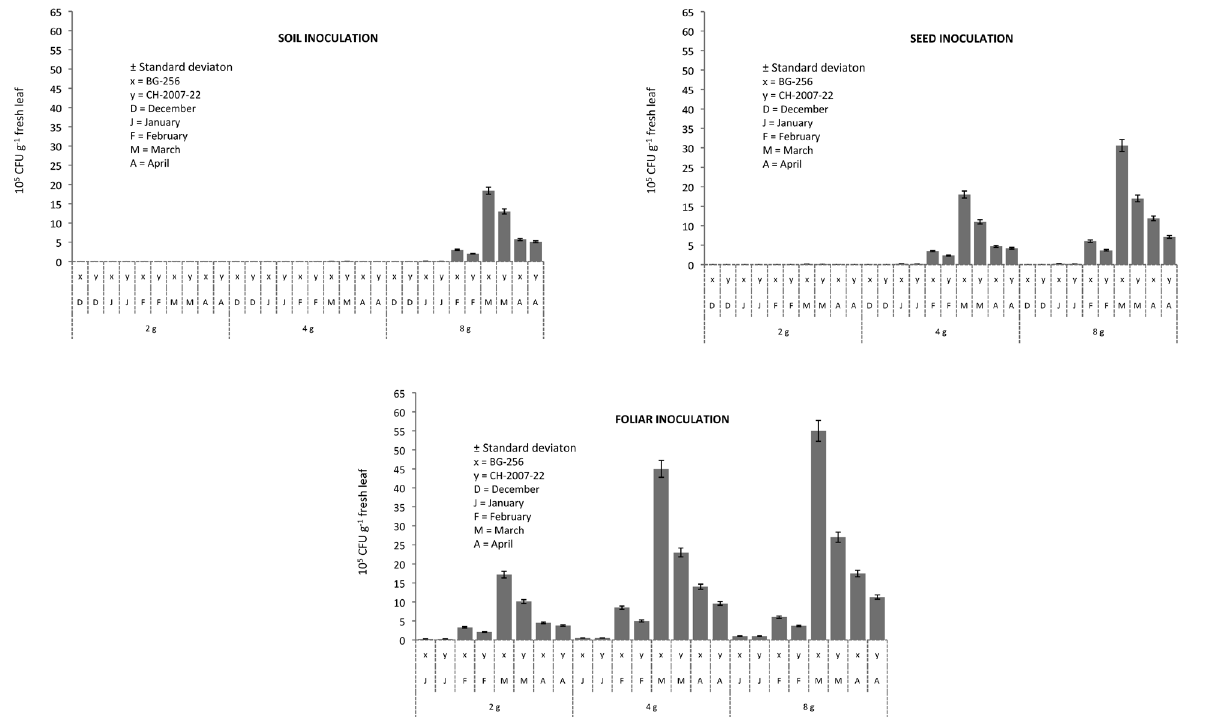
Figure 1. Phylloplane population of Botrytis cinerea in the most tolerant and susceptible chickpea cultivars subjected to soil, seed and foliar inoculation with B.